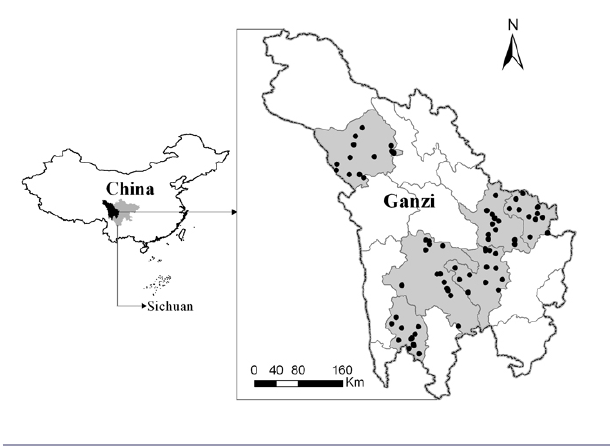
Fig. 1. The six sampled counties (right, gray) and 74 surveyed monasteries (right, black dots) in Ganzi Prefecture, Sichuan Province,